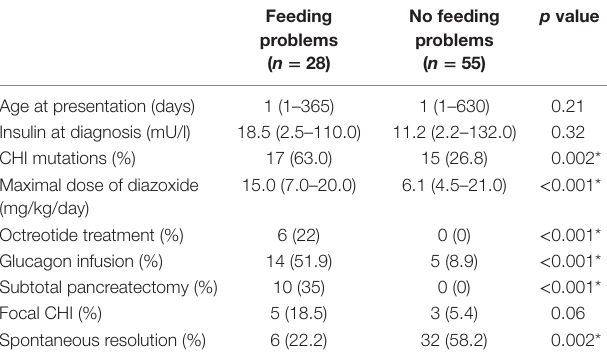
TaBle 1 | Differences between groups of children with and without feeding problems (FPs): continuous variables are represented as median (range) values, while categorical variables are represented as percentages.